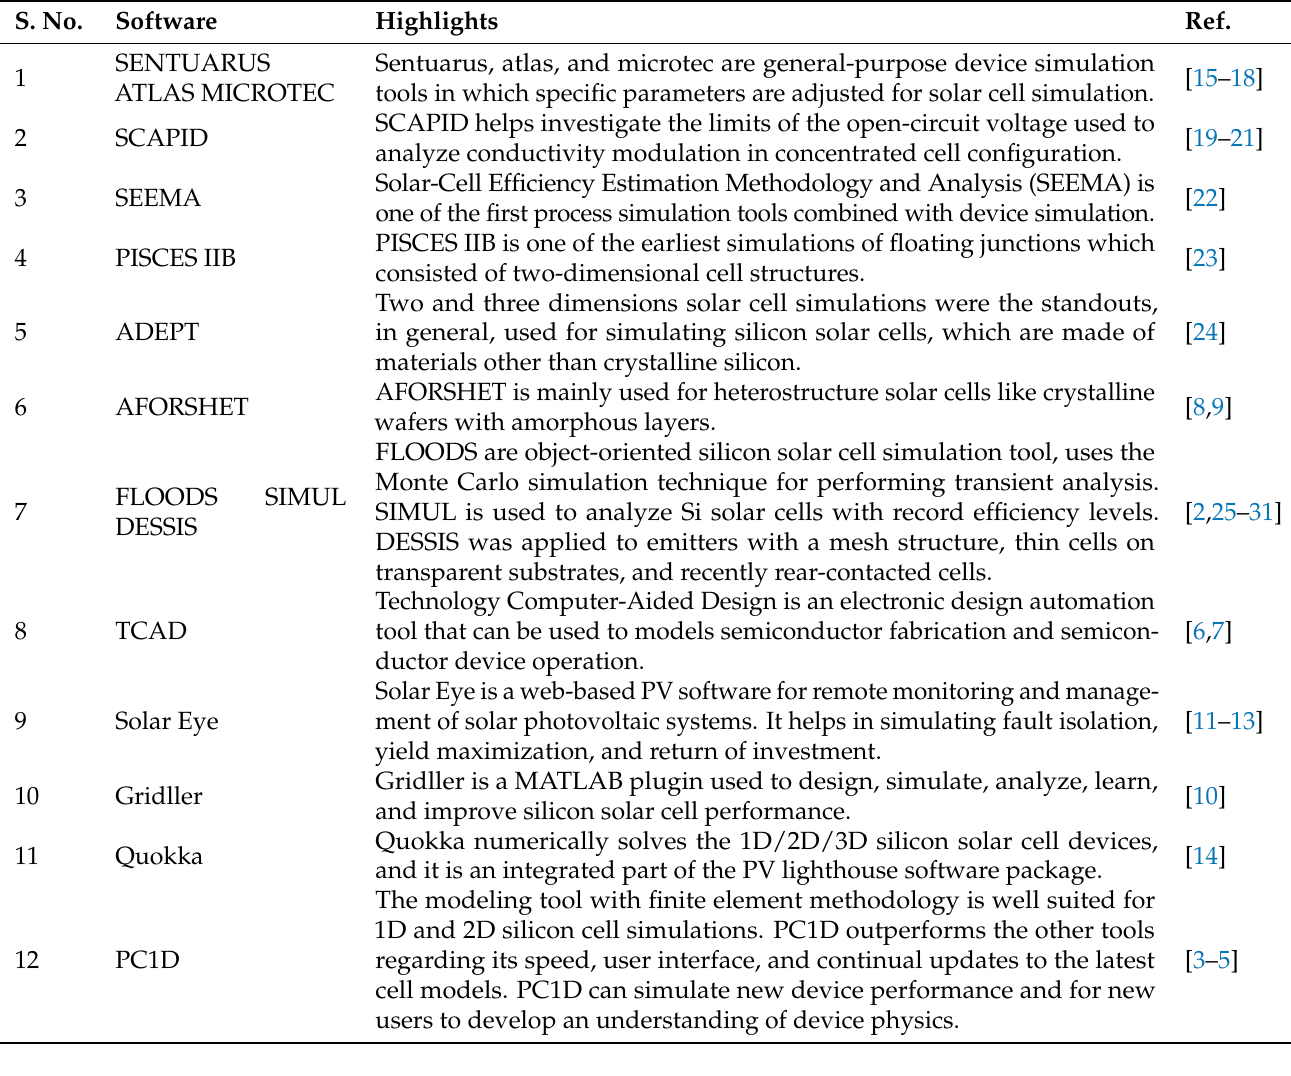
Table 1. Overview of numerical simulation tools used for simulating Silicon solar cell devices. S. No.